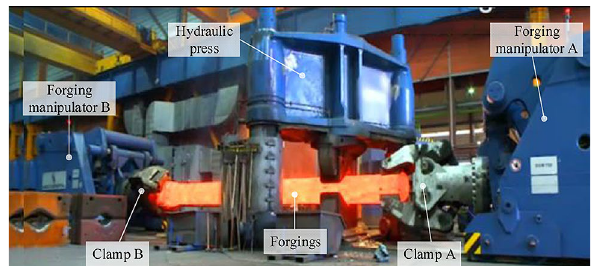
Figure 1. DDS released a double forging manipulator operating the example.